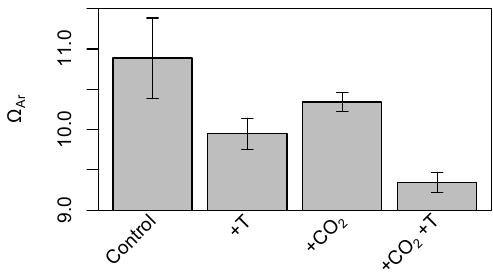
Figure 8. Raman-derived (cid:127) Ar of Acropora cultured under different temperature and CO 2 treatments. The grey bars indicate treatment means and error bars represent ± standard error of the mean. Sig- nificant effects were observed for both temperature and CO 2